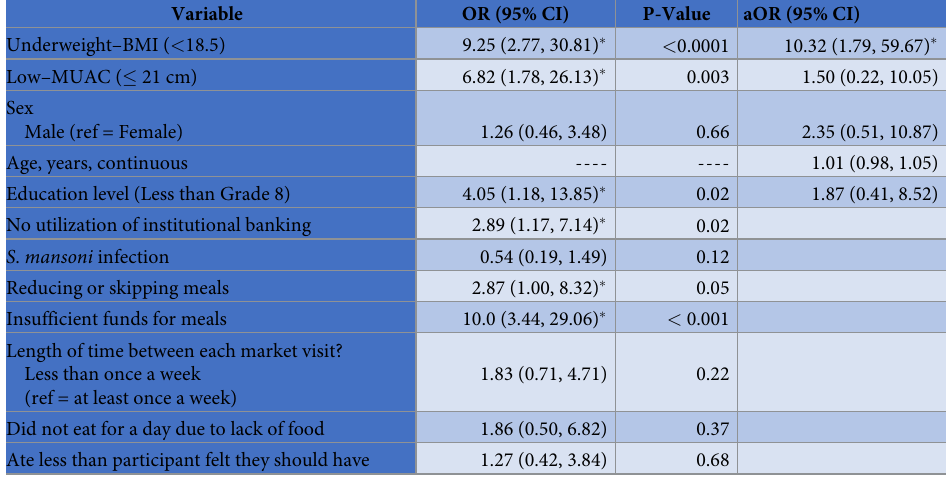
Table 2. Univariate analysis and multivariate logistic regression of study outcome, leprosy, and demographic, nutritional, infectious, and food security questions. Variables without an aOR were either not included or were dropped from the final model per the